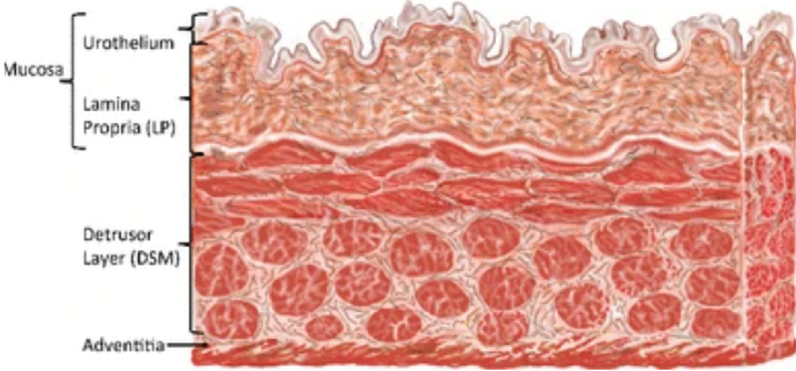
Figure 1. Diagram of the bladder wall structure. Figure modified and permission obtained from